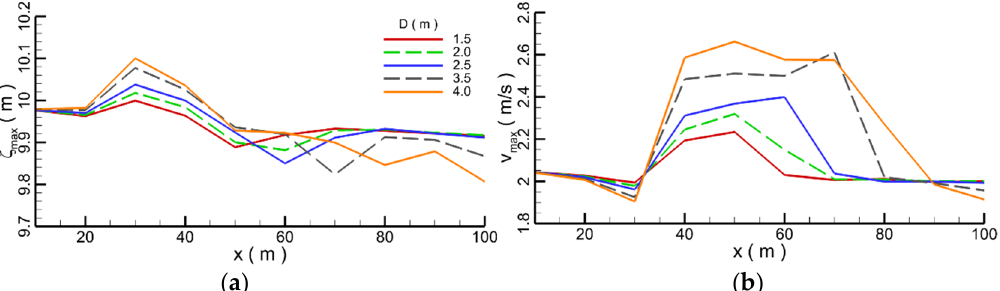
Figure 13. The maximum water level and velocity recorded under different diameters; ( a ) water level; ( b ) velocity. ( b )